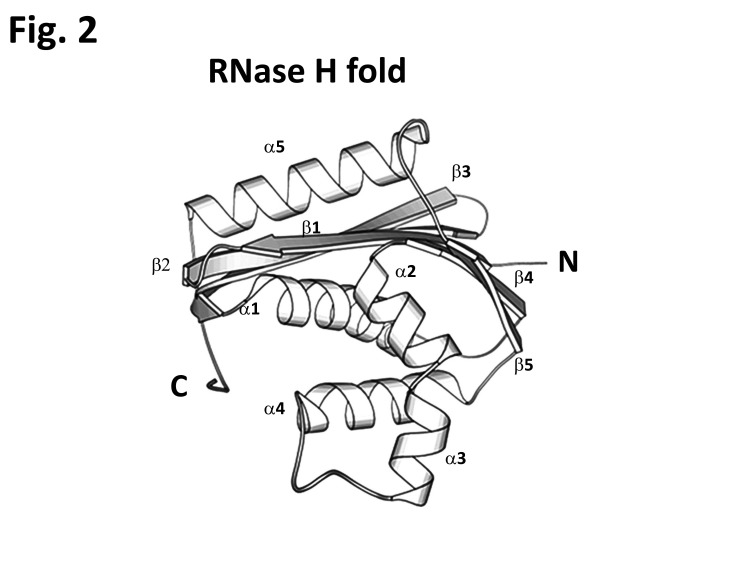
E. coli RNase H foldingwith a b1-b2-b3-a1-b4-a2/3-b5-a4-a5 sequence revealed in 1990 by Yang et al.38 (PDB code 1RNH.pdb).